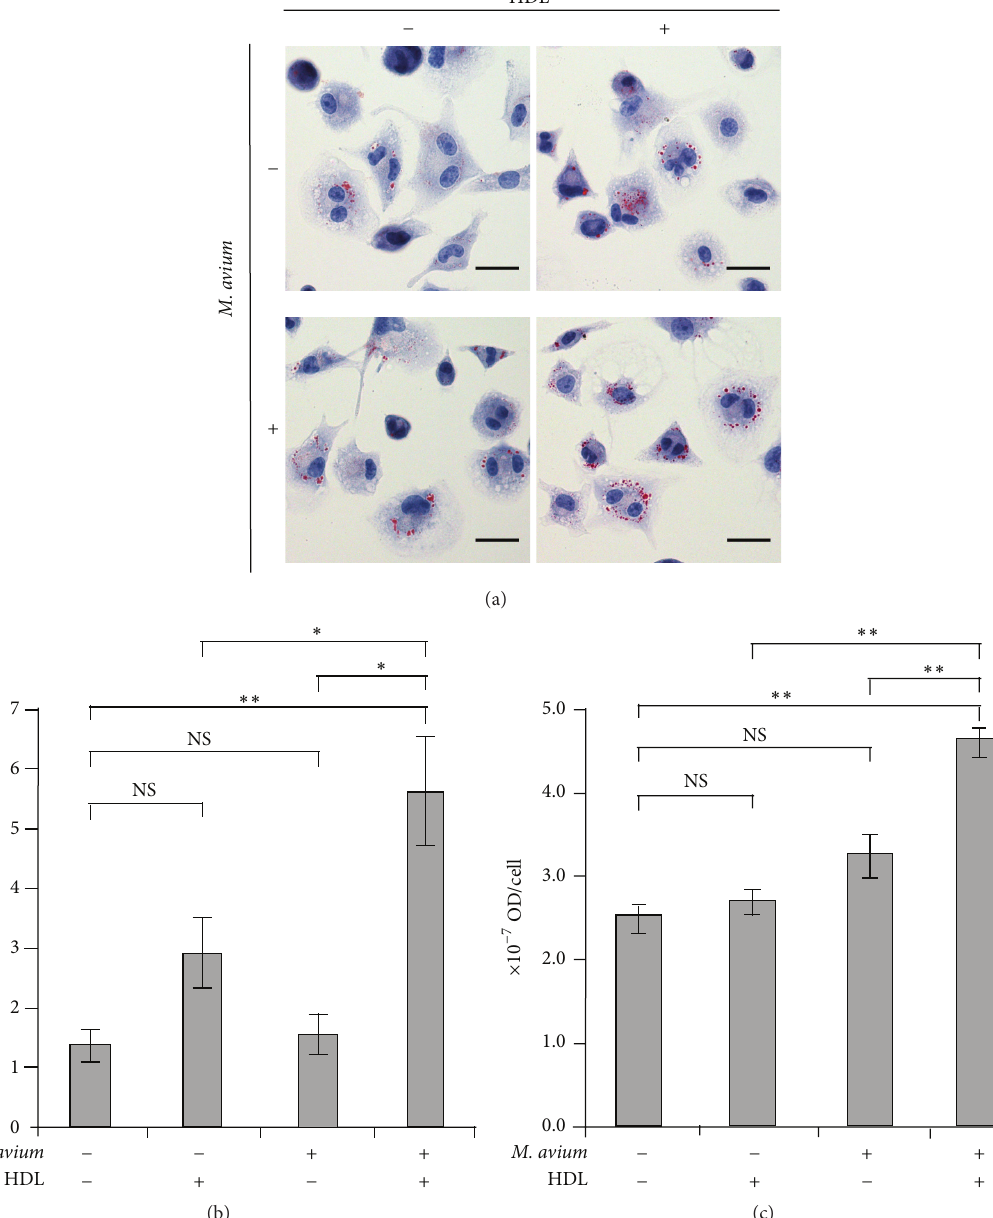
Figure 6: High-density lipoprotein (HDL) promotes a formation of THP-1 macrophage-derived foam cells during M. avium infection. THP-1 macrophages were infected by M. avium with (+) or without ( − ) HDL. (a) Representative light microscopic images of the cells stained with Oil red O (ORO) and hematoxylin are shown. The scale bar is 25nm. (b) The numbers of lipid droplets (LDs) per cell were calculated by counting of those number for 50 cells. (c) The amount of LDs was also quantitatively analyzed by measuring absorbance (at 540nm) of ORO extracted from the cells. The values were indicated by mean ± SEM ( 𝑛 = 3 , ∗ 𝑃 < 0.05 , ∗∗ 𝑃 < 0.01 ). NS: not